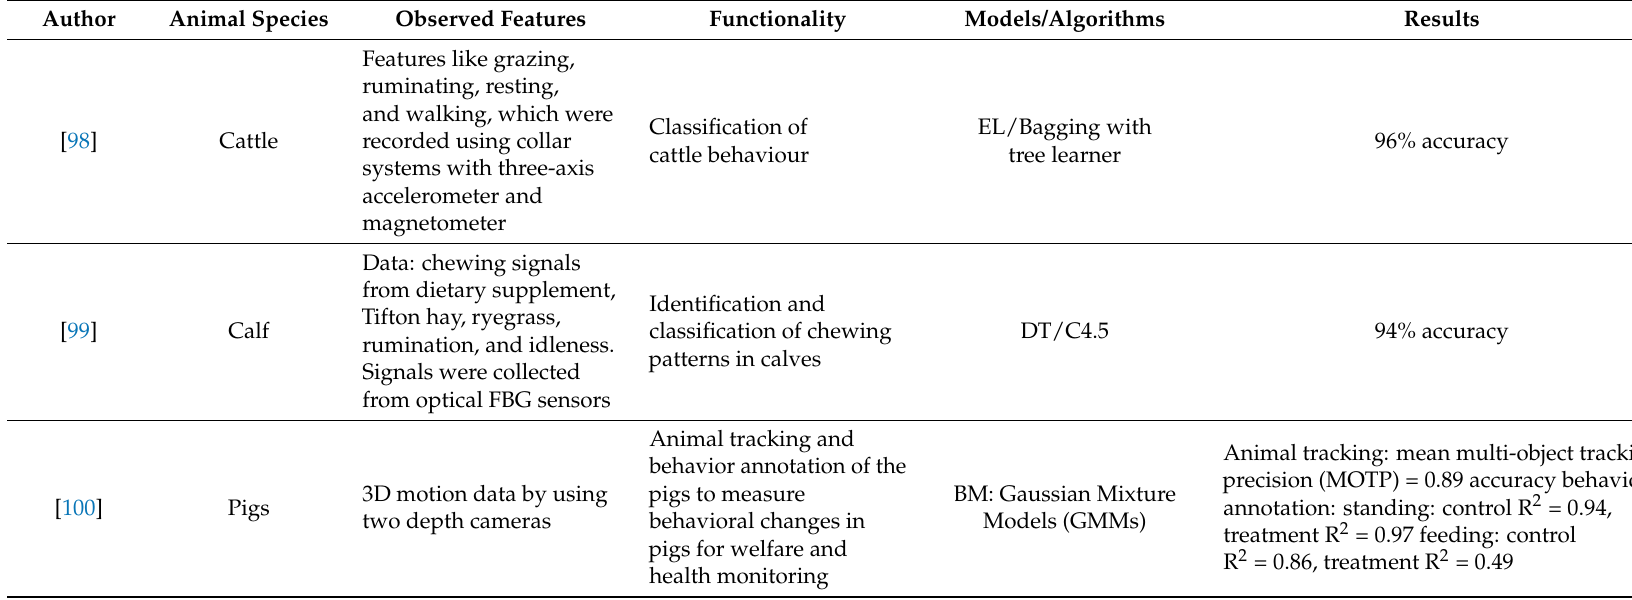
Table 10. Livestock: animal